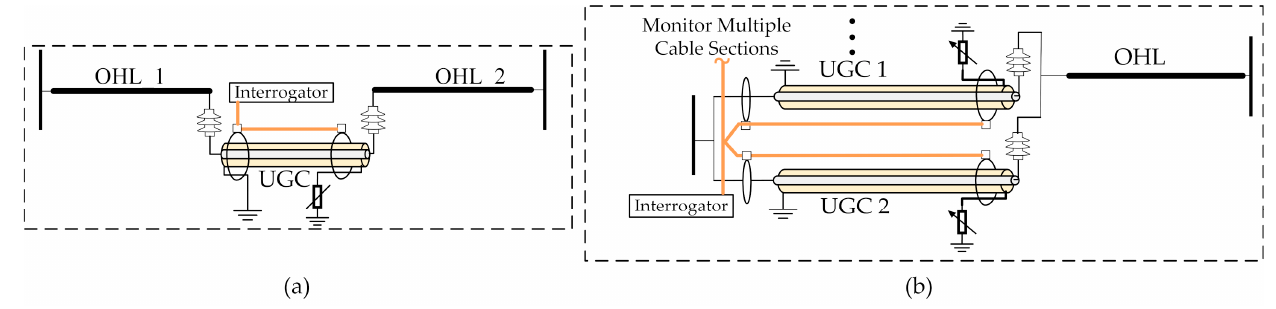
Figure 8. Mixed conductor circuit topologies; ( a ) two-ended circuit with UGC section between two OHL sections, ( b ) two-ended circuit with multiple UGC sections.